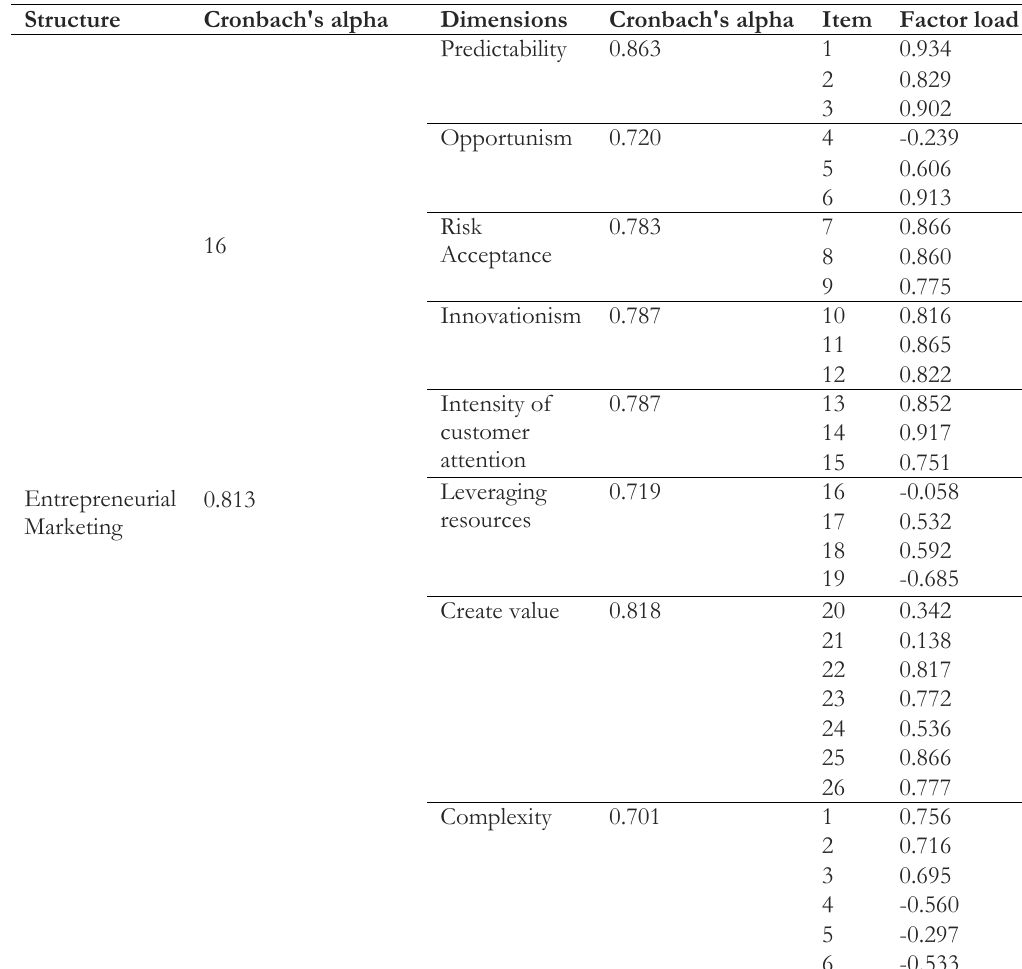
Table 1. Validity and reliability results of the questionnaire by